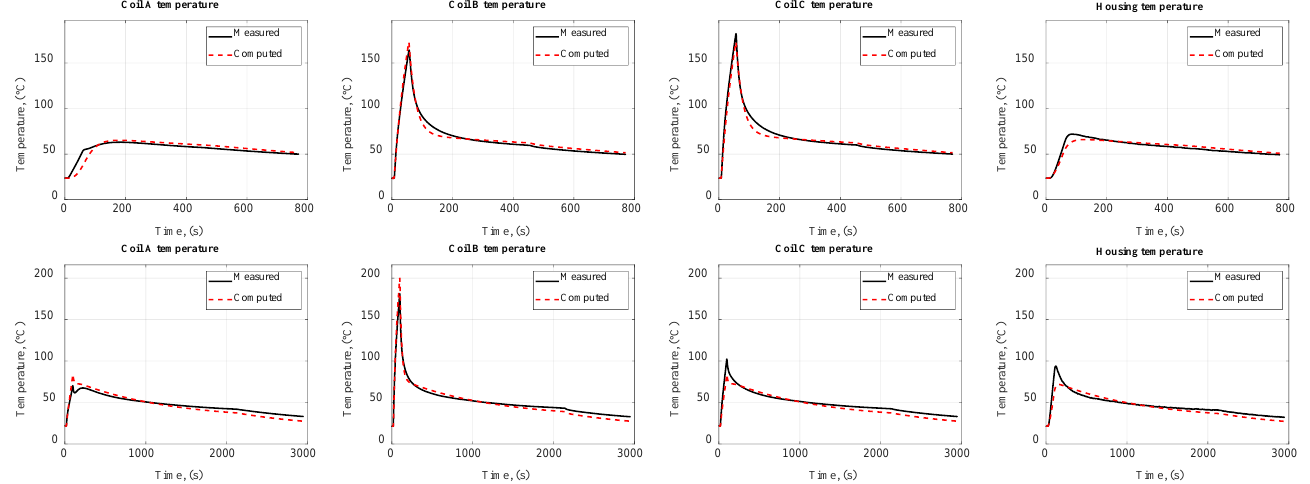
Figure 19. Measured and computed temperatures for the short-time pulse tests: in configuration A ( top ); in configuration B ( bottom ). Table 4. Percentage errors for the long-time pulse tests shown in Figures 8, 9 and 18 (evaluated at